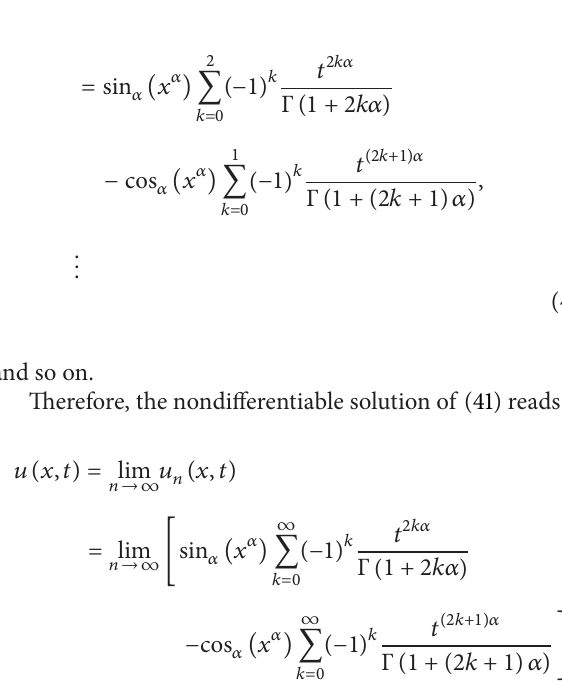
Figure 4: The plot of solution of (41) when 𝛼 = ln 2/ ln 3